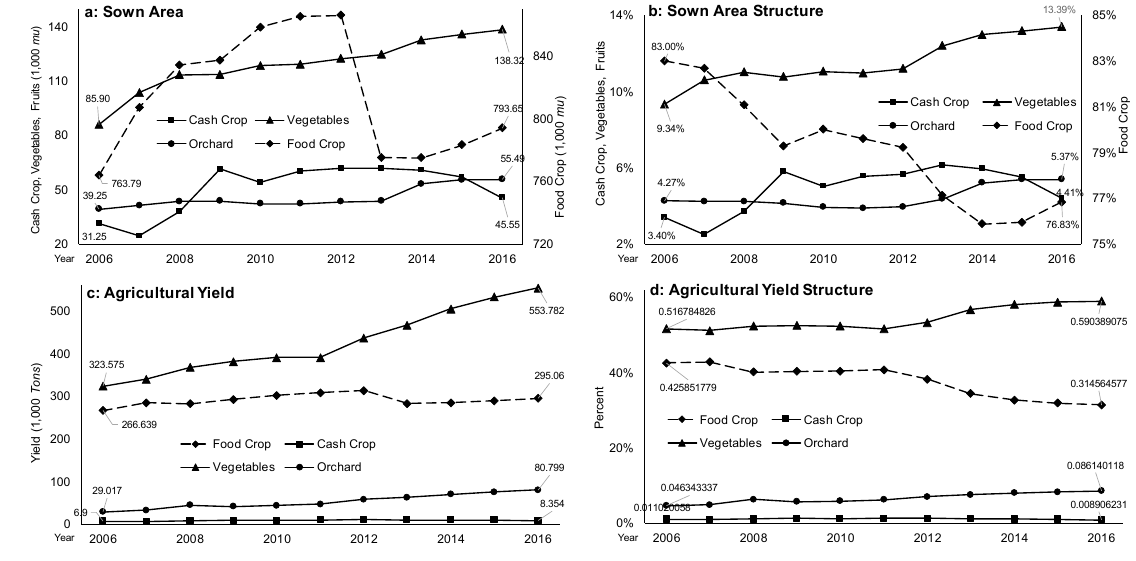
Figure 6. Sown area and the yield and structure of crops in Xichang from 2006–16.